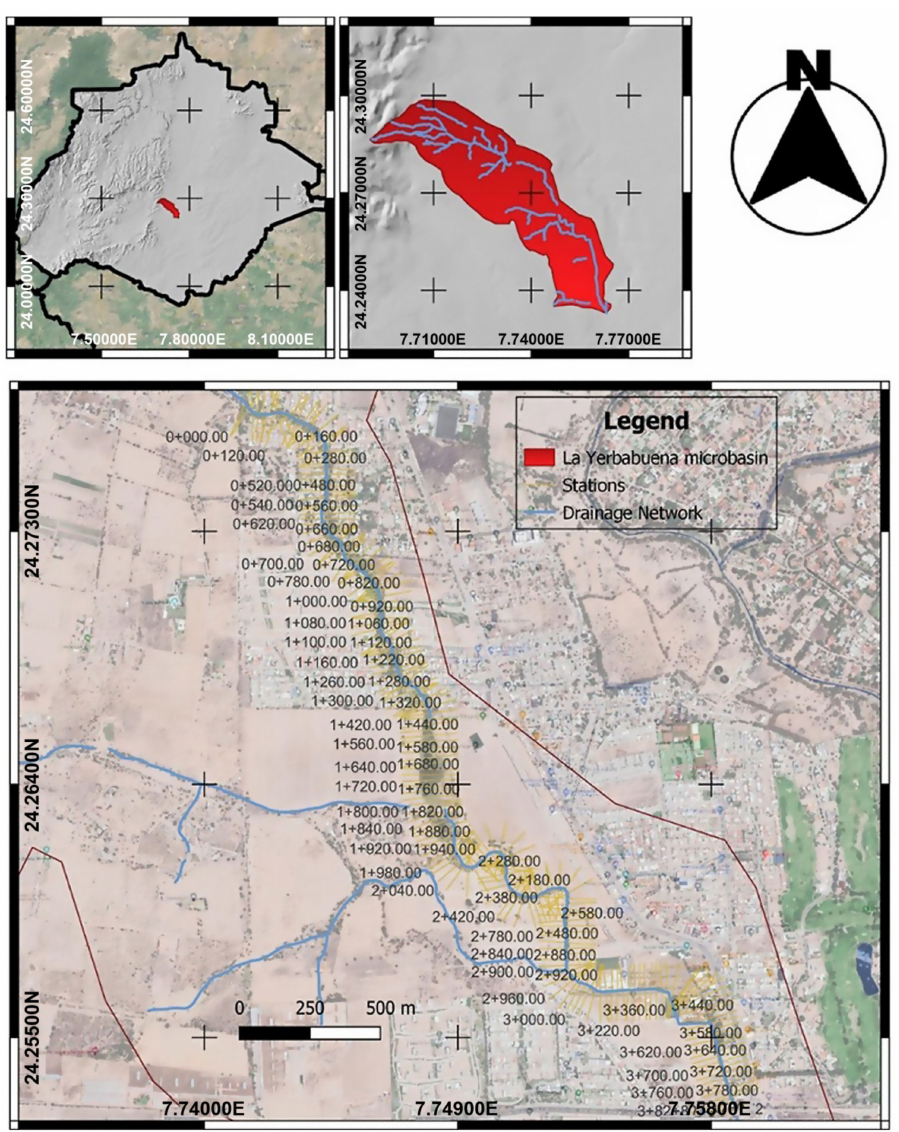
Figure 8. Suburban section selected (largest map) from the main stream. Stations in the figure refer to